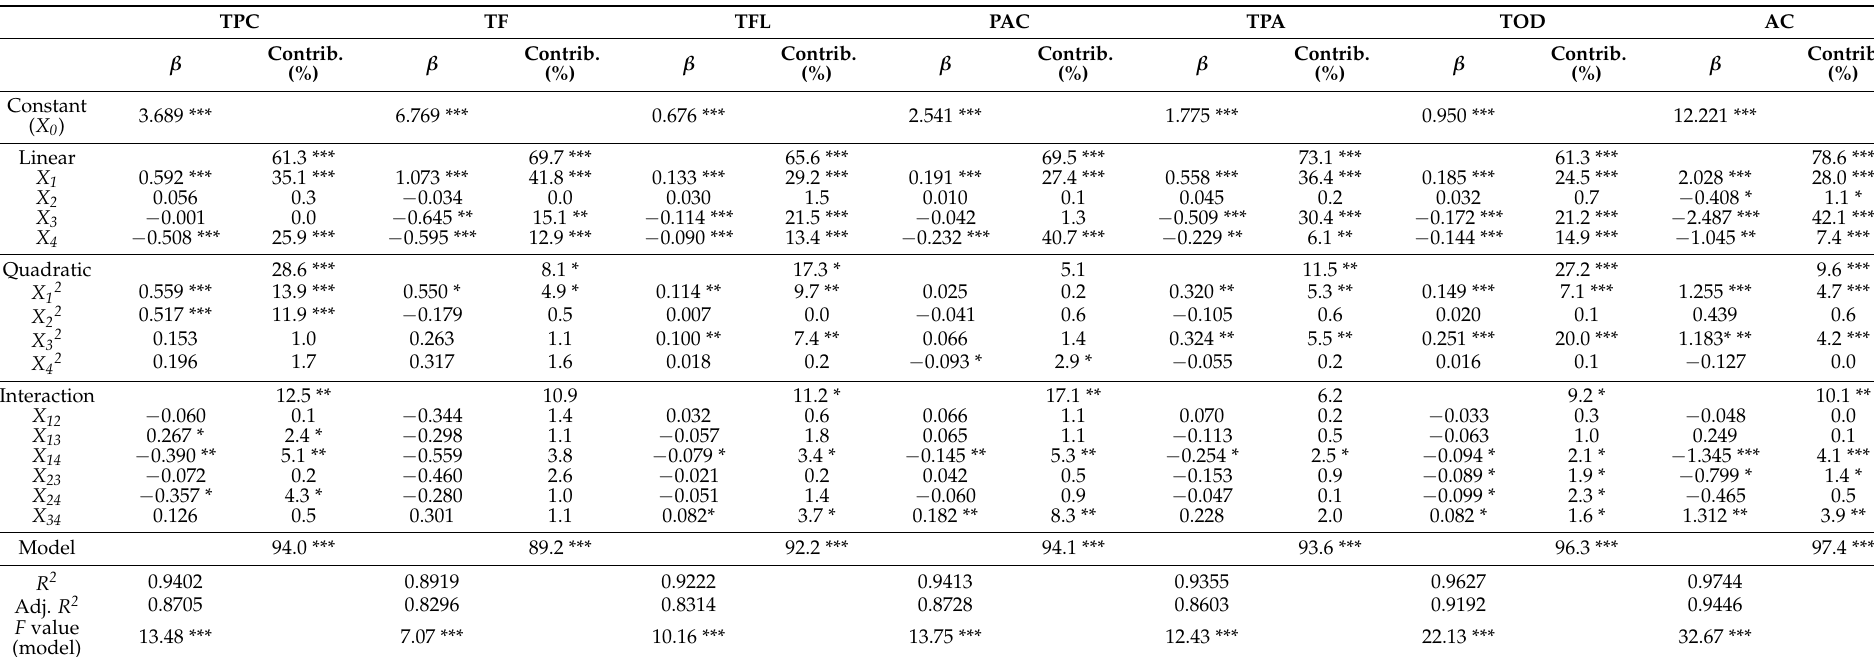
Table 3. Regression coefficient ( β ), contribution, coefficient of determination ( R 2 and Adj. R 2 ), and F -test value of the predicted second-order polynomial models for the phenolic compounds and antioxidant